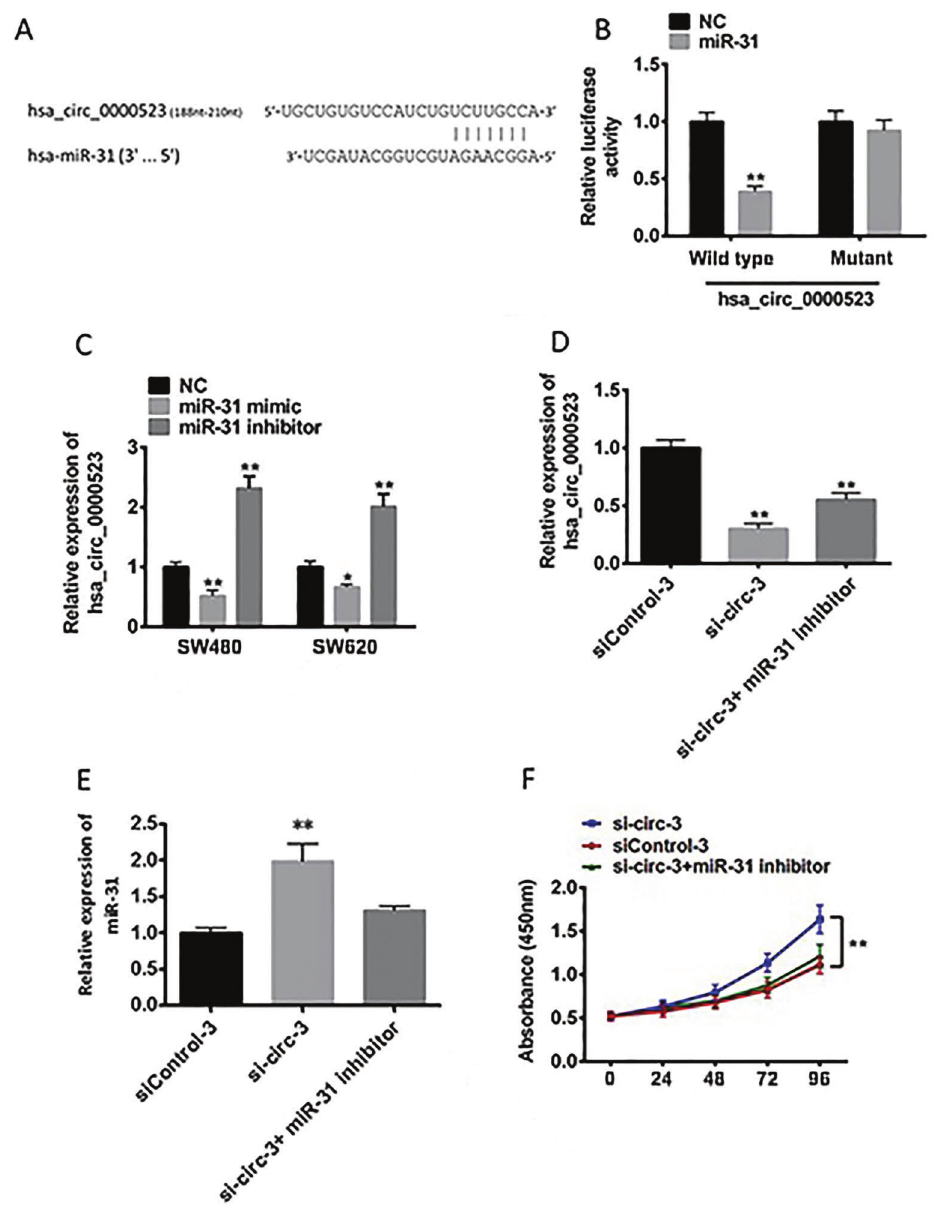
Figure 4. A , Schematic representation of miR-31 and predicted target site in hsa_circ_0000523. B , HEK293A cells were co-transfected with reporter carrying the predicted target of miR-31 in hsa_circ_0000523 and the corresponding small RNA, assessed using a dual- luciferase reporter assay system and compared to normal control (NC) transfection. C , hsa_circ_0000523 expression levels in SW480 and SW620 cells after transfection with miR-31 or miR-31 inhibitor. D , hsa_circ_0000523 expression levels in SW480 cells after transfection with si-circ_0000523-3 or co-transfection of si-circ_0000523-3, and miR-31 inhibitor. E , miR-31 expression levels in SW480 cells after transfection with si-circ_0000523-3 or co-transfection of si-circ_0000523-3, and miR-31 inhibitor. CircRNA and miRNA expression levels were assessed by qPCR and normalized to GAPDH or U6. F , Cell viability of SW480 assessed using CCK8 assay after transfection with si-circ_0000523-3 or co-transfection of si-circ_0000523-3 and miR-31 inhibitor. The assays were performed in triplicate independently. Data are reported as means ± SE. *P o 0.05; **P o 0.01